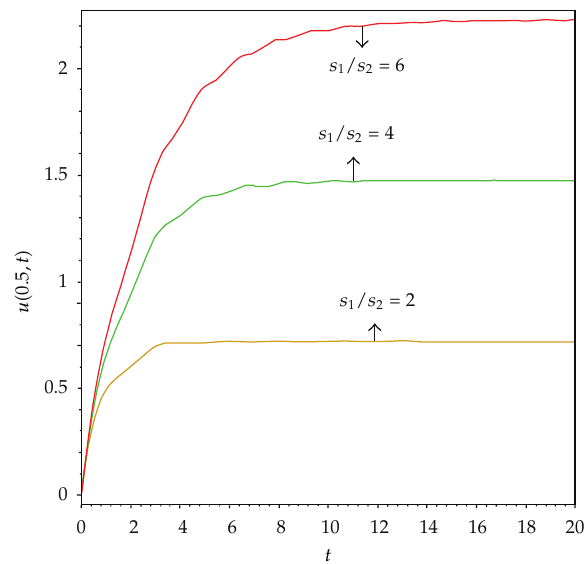
Figure 5: The e ff ect of the elasticity on the centerline velocity profile for μ 1 (cid:8) 10 and h (cid:8) 1 for impermeable